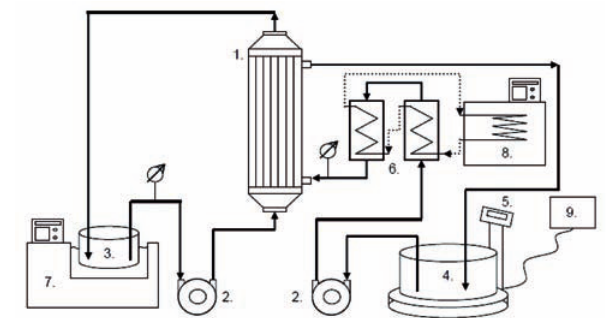
Figure 2. Laboratory scale osmotic distillation equipment. 1. membrane module, 2. peristaltic pumps, 3. sour cherry juice, 4. saturated CaCl2